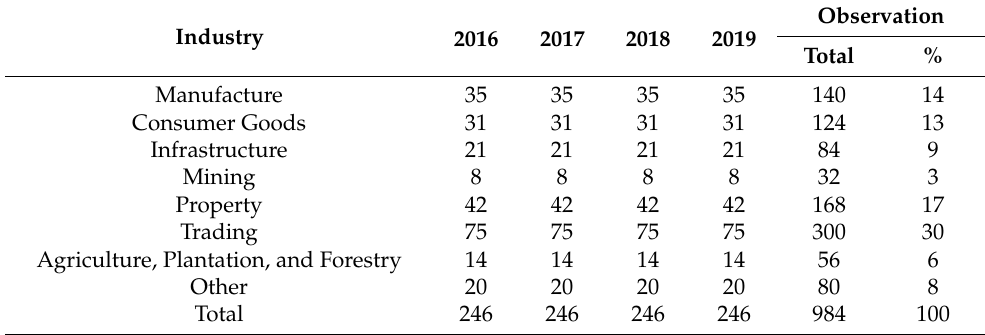
Table 1. Distribution of firm-year observations by industry and year. Source: Processed